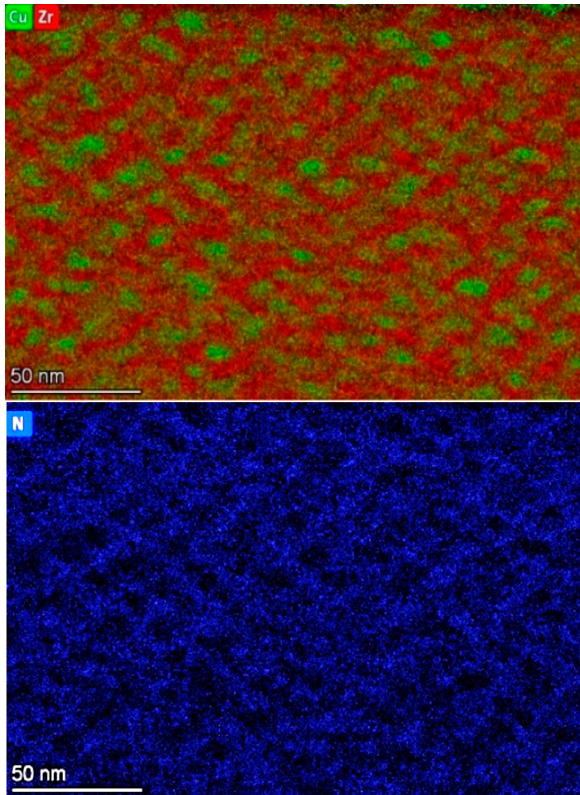
Figure 7. Cu/Zr (top) and N (bottom) TEM-EDS maps of the Cu29